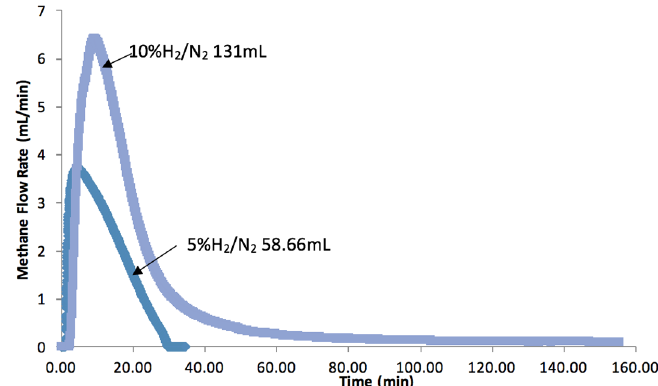
Figure 6. Methane production comparison of 5% H 2 /N 2 and 10% H 2 /N 2 . The test was operated using 10 grams of 5% Ru, 10% Na 2 CO 3 /Al 2 O 3 pellets in the large fixed bed reactor. The operational conditions were at 320 °C, 300 mL/min of 7.5% CO 2 /N 2 for CO 2 adsorption. The volume of methane produced are shown.